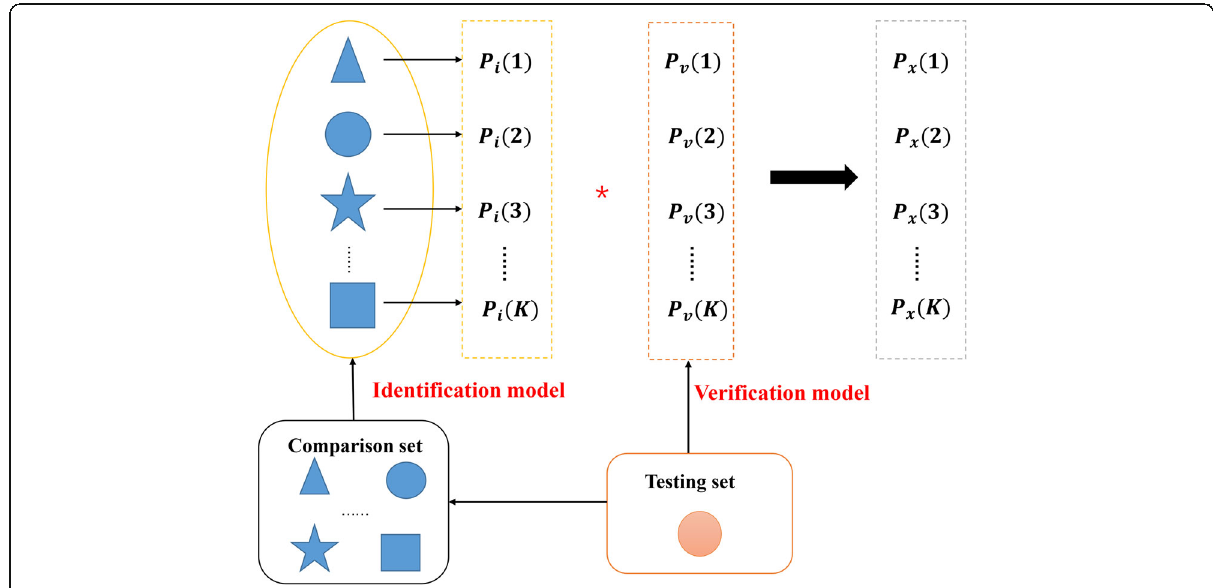
Fig. 2 The visualization of the joint decision-making mechanism. Each shape represents a scene class. One test image along with the images in the comparison set is fed through the whole network. The identification model outputs the class probability Pi( j ) ( j = 1, 2, ..., K ) of images in the comparison set. Meanwhile, the verification model outputs the similarity measurement Pv( j ) which is the relationship score between the test image and every single image in the comparison set. A set of P (x)(P1(x), P2(x), ..., PK(x)) can be obtained based on Eq.